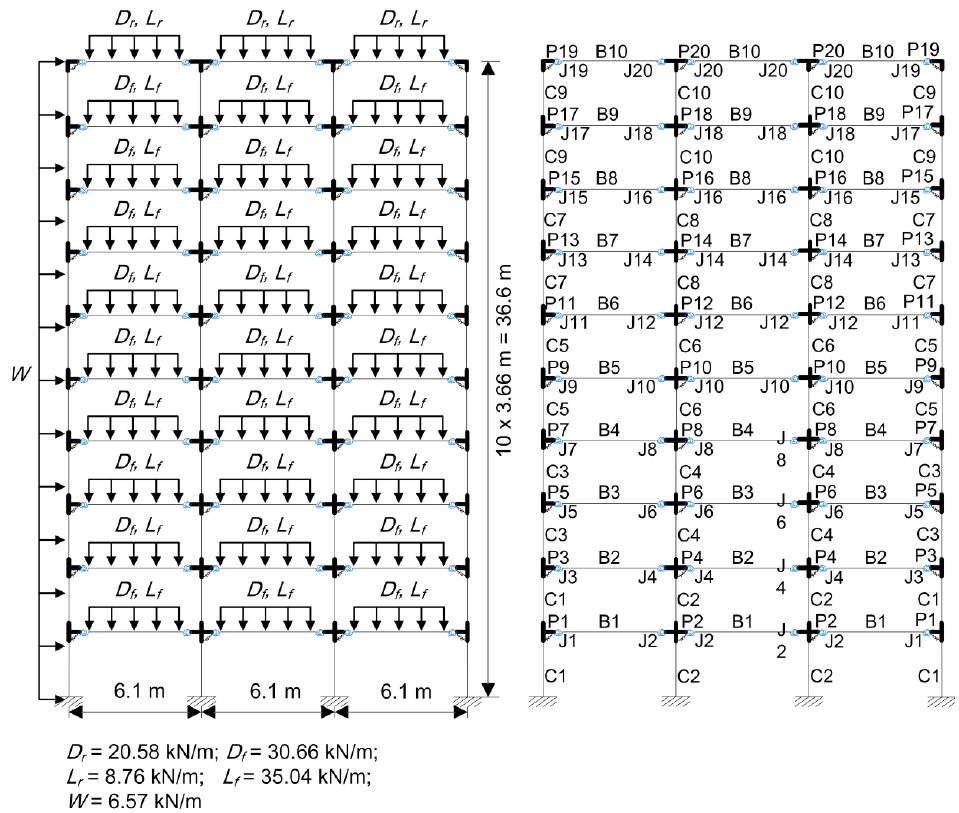
Figure 20. Three-bay ten-story frame.